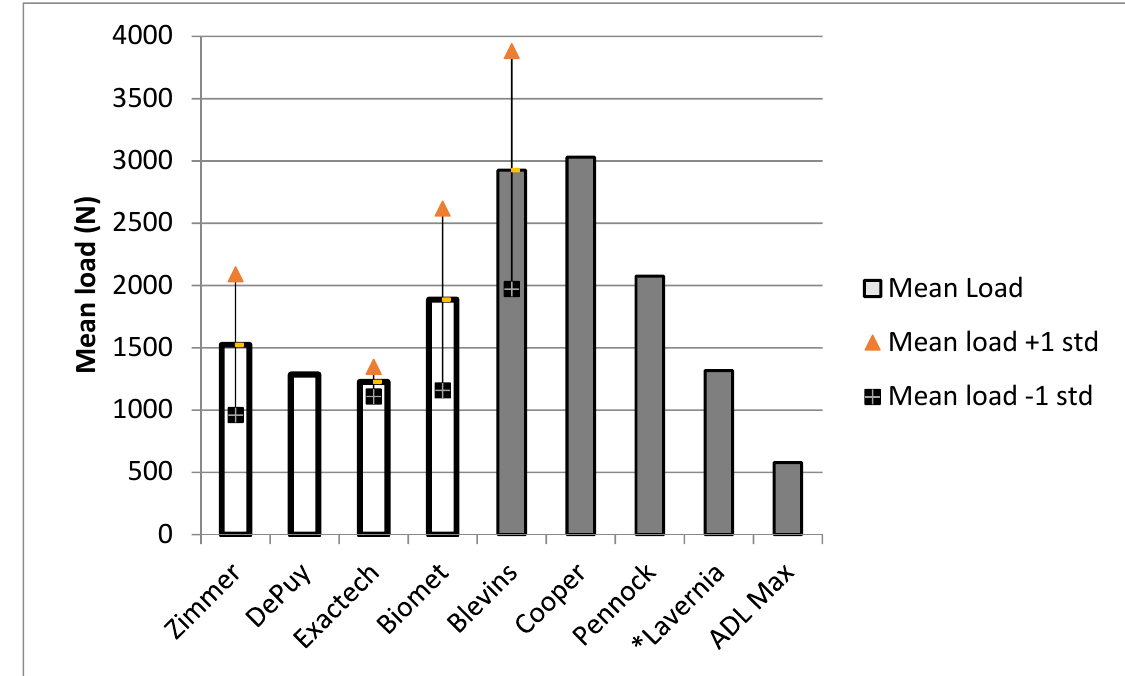
Figure 1. Mean load to dissociation compared to ADL max. *: The Lavernia data in Figure 1 represent an average of the mean dissociation forces across five trials of four different clean tapers. Table 2. Implant group mean load to failure.